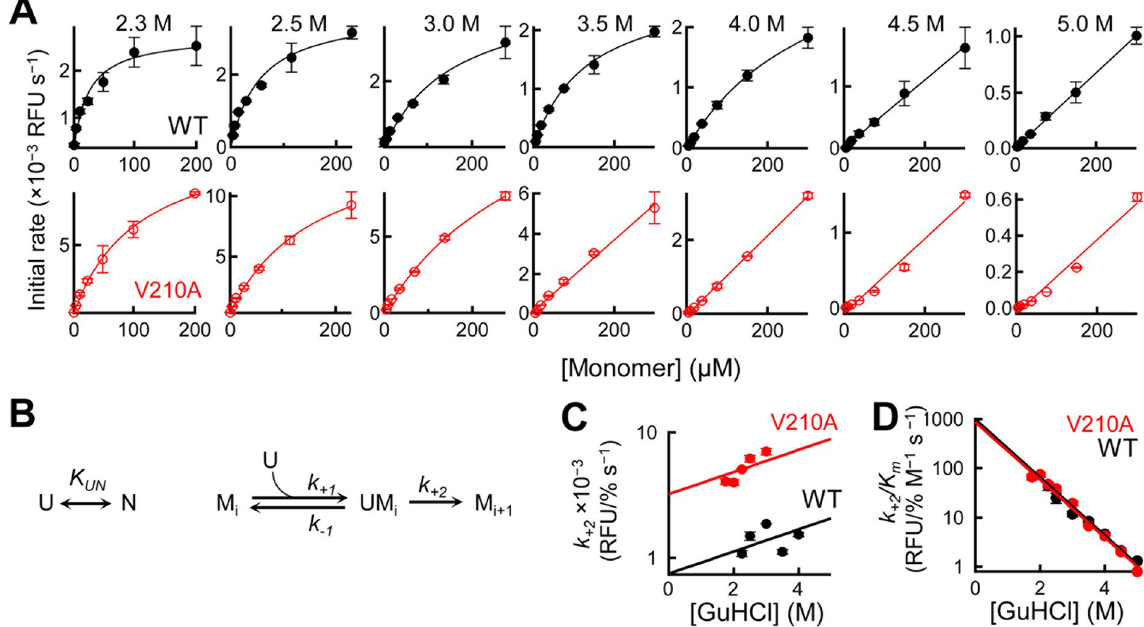
Figure 3. Effects of varying the concentration of the U state on amyloid growth. ( A ) Initial growth rates as the function of the total concentration of monomers (WT [top row] and V210A [bottom row]). The growth reaction was seeded with 2.5% WT amyloid. The solid lines are least-squares fits to the Michaelis–Menten function (Equation 2). ( B ) Two-step reaction model for amyloid growth. ( C,D ) Elementary constants derived from Fig. 3A as a function of the concentration of GuHCl [ k + 2 ( C ) and k + 2 / K m ( D )]. Note: 1 relative fluorescence unit (RFU)/% s − 1 ≈ 1.2 × 10 3 s − 1 (SI text